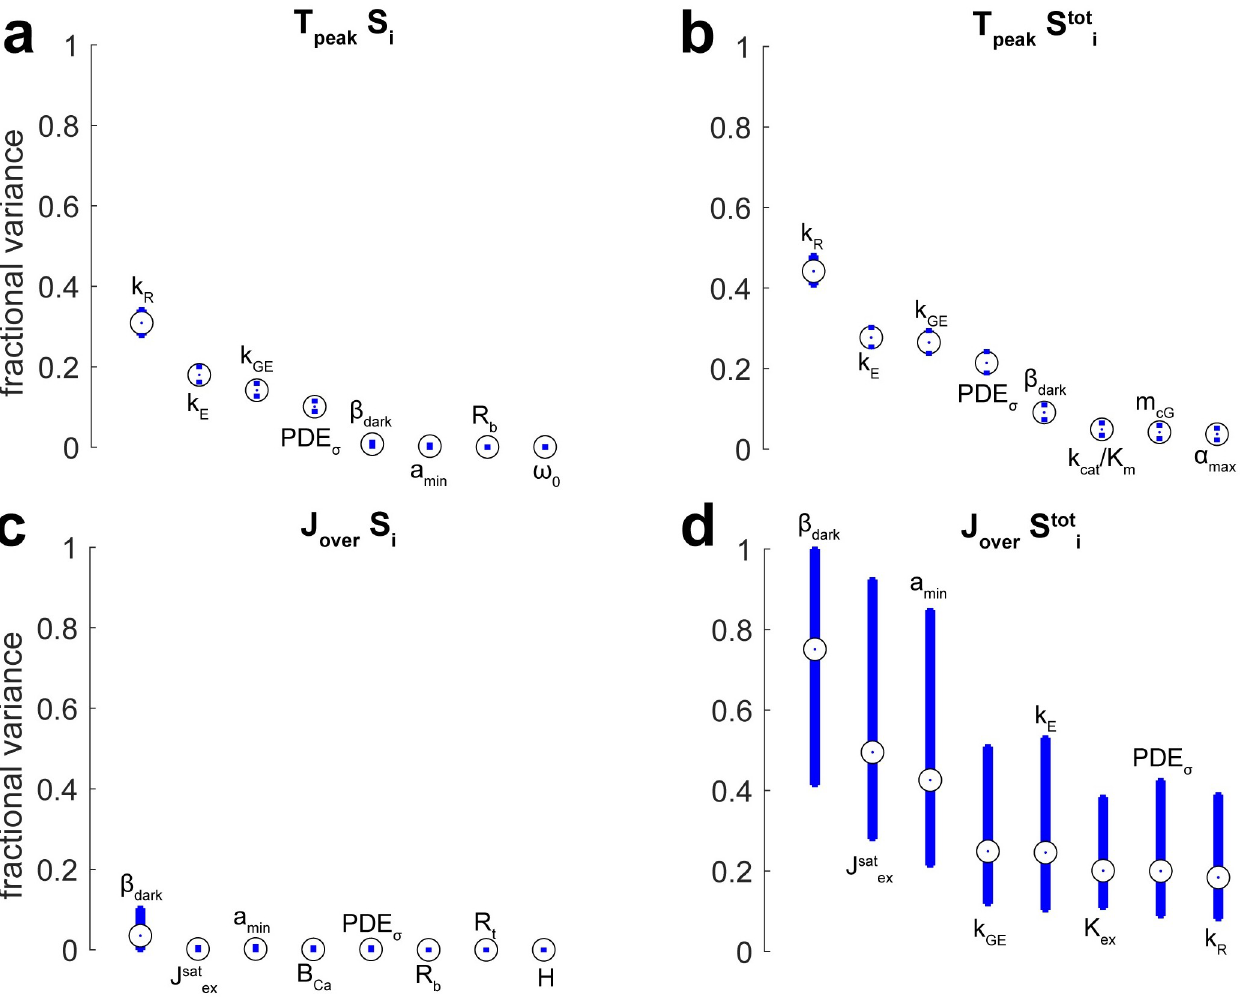
Fig 4. Sobol indices for functionals quantifying the time-to-peak of the current drop and its overshoot. Blue bars define a 90% confidence interval (100,000 samples). Plots show the eight most influential parameters. Confidence intervals could be off-center of the estimated Sobol index, because the indices were ratios of two Monte Carlo estimated quantities. (a) Single sensitivity indices for the time-to-peak. (b) Total sensitivity indices for the time-to-peak. (c) Single sensitivity indices for the overshoot. (d) Total sensitivity indices for the